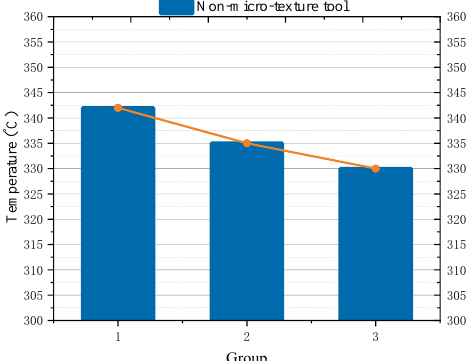
Figure 5. Cutting temperature of non-micro−texture tool.